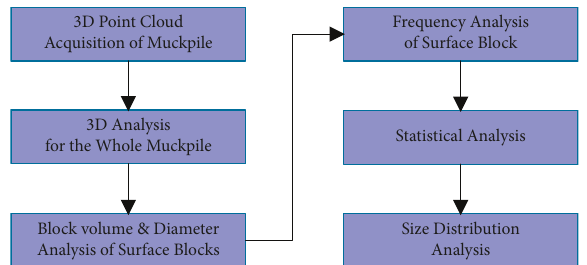
Figure 6: Flowchart of fragmentation analysis based on 3D laser scanning technology (3D